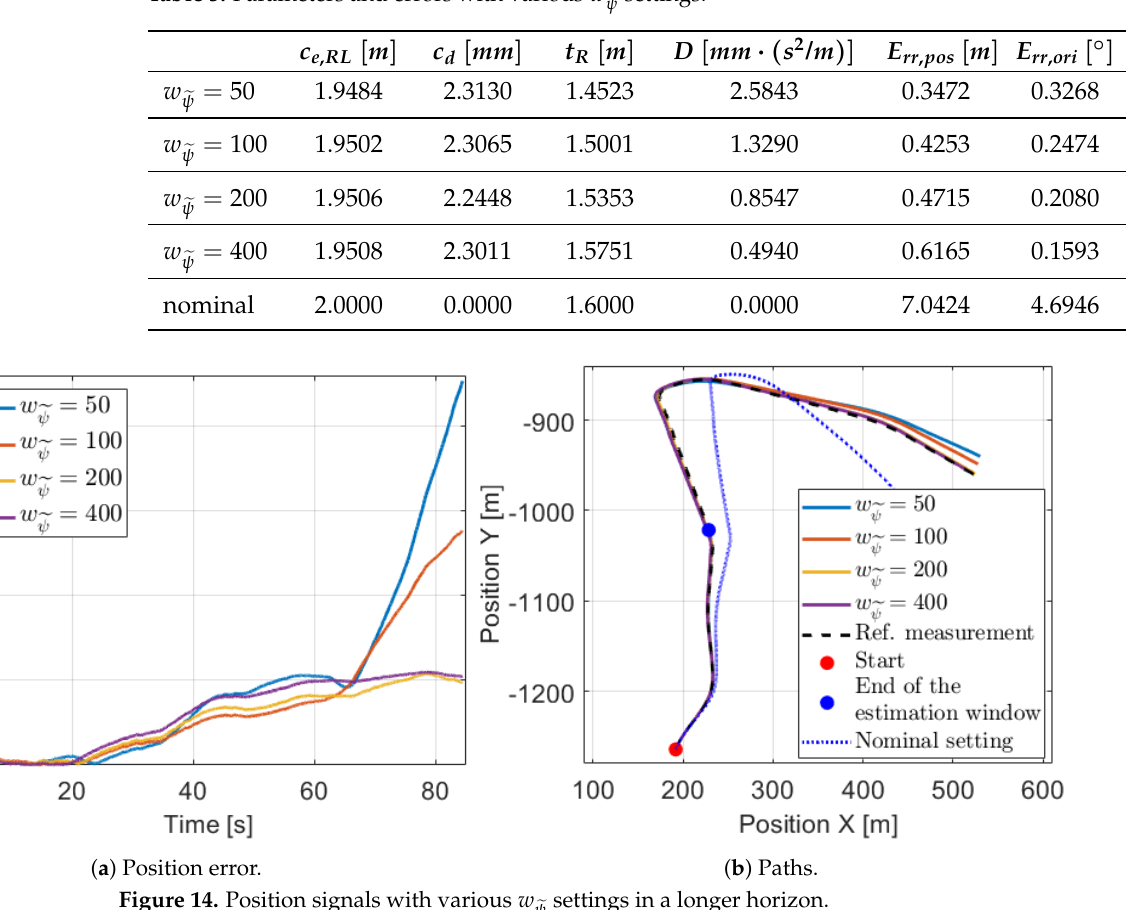
Table 3. Parameters and errors with various w